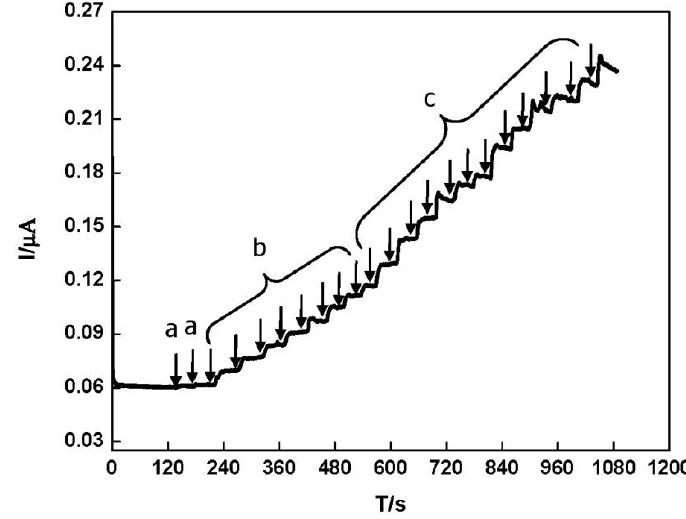
Figure 8. Typical current-time response curve for successive addition of 0.1 mM H O obtained by DNA/chitosan/GCE ( a ), DNA/chitosan/HRP/GCE ( b ) and 2 2 DNA/chitosan/Fe O /HRP/GCE ( c ) in 0.1M phosphate buffer (pH 7.0) at applied potential 3 4 of −0.25 V. Inset: the plots of amperometric responses (Δ I ) vs. H